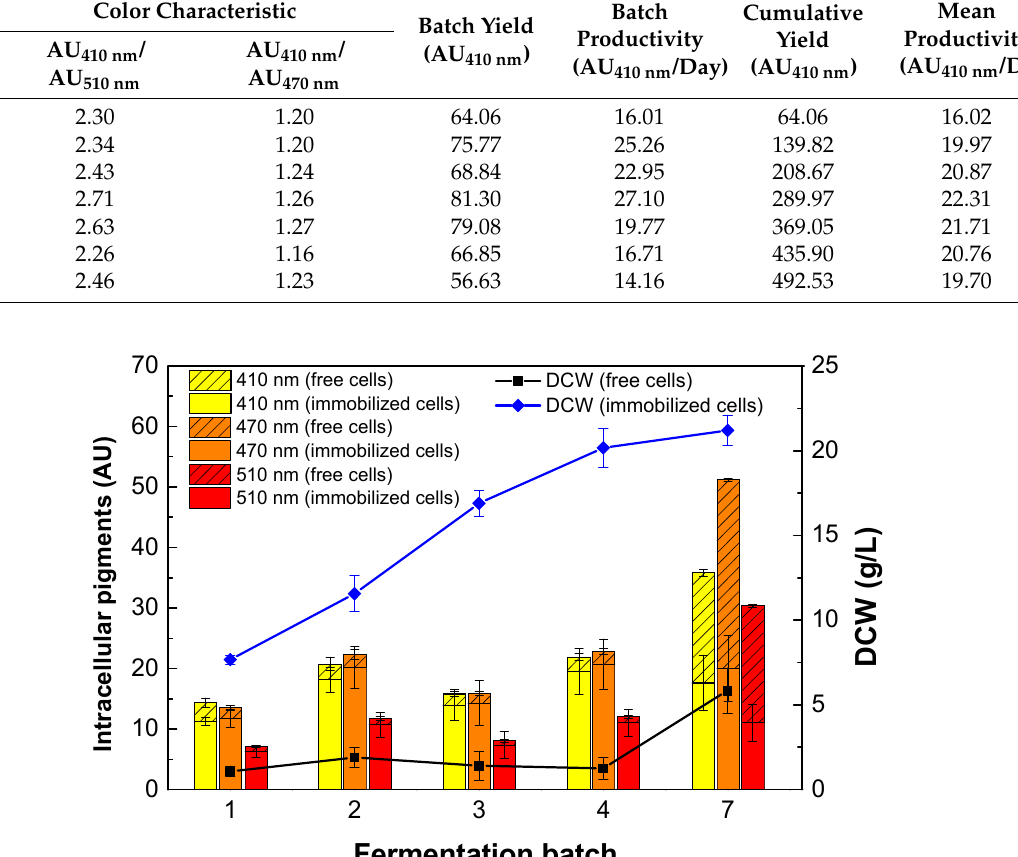
Figure 5. Spectra of extracellular pigments at the end of each batch in repeated-batch extractive fermentation with immobilized cells. Table 2. Production of extracellular pigments in repeated-batch extractive fermentation with immobi- lized cells.